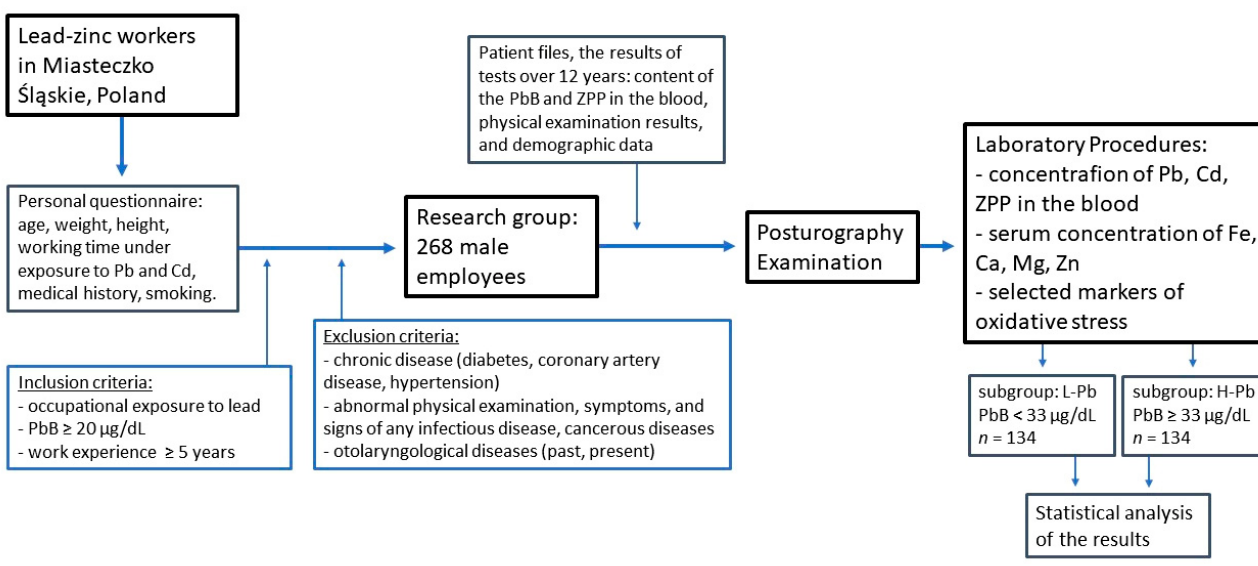
Figure 4. Flowchart of the study of the relationship between postural stability, blood lead concentration, and selected parameters of oxidative stress. ZPP—zinc protoporphyrin concentration, PbB—blood lead concentration, L-Pb—low-PbB-level subgroup, H-Pb—high-PbB-level subgroup.